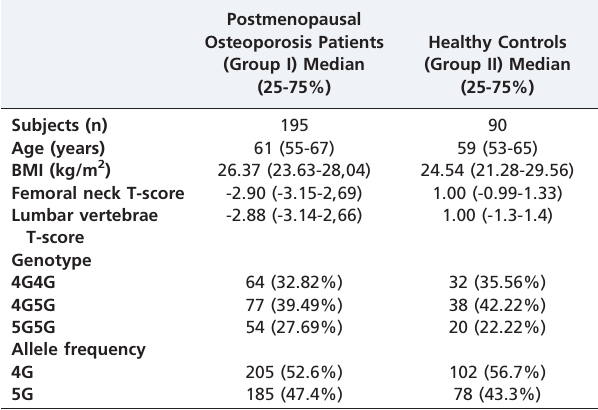
Table 1 - Age, body mass index, femoral neck and lumbar vertebrae T-score averages and 4G/5G PAI-1 gene distribution in both groups. Postmenopausal Osteoporosis